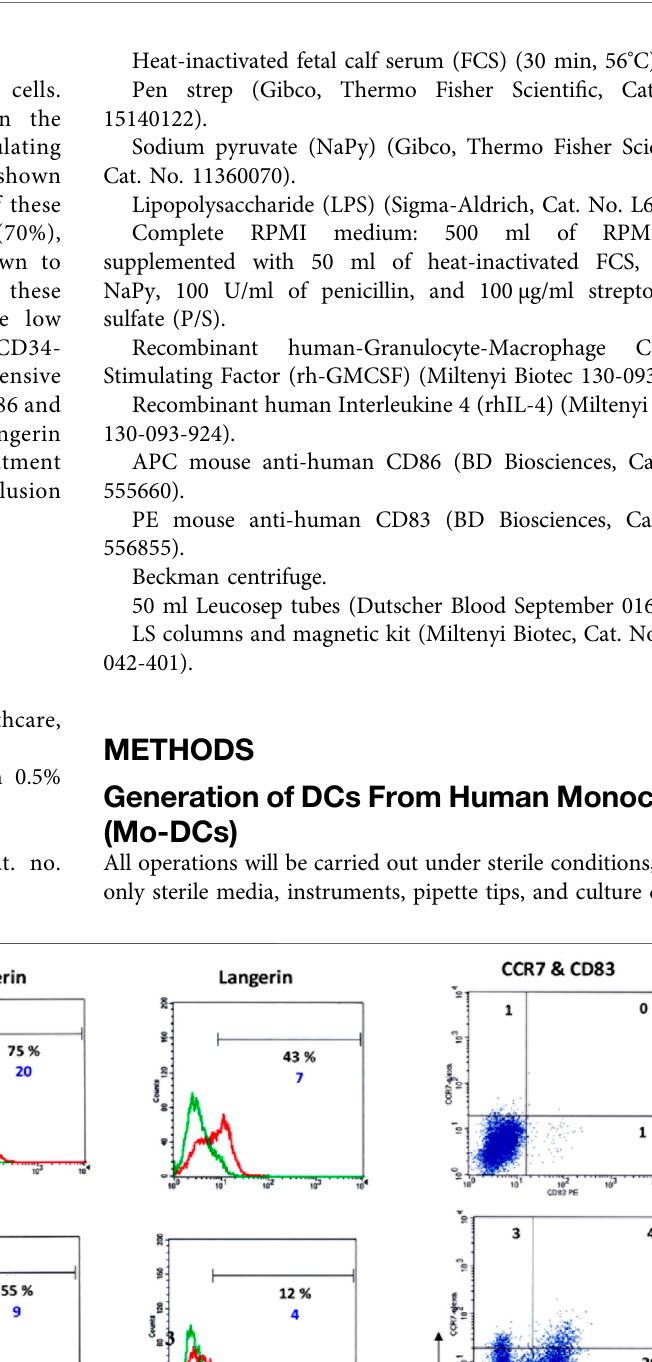
Frontiers in Toxicology |